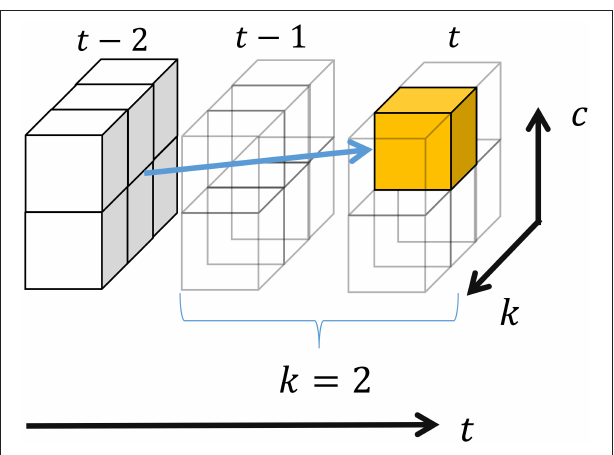
FIGURE 6 | Recursive computation in forward filtering.